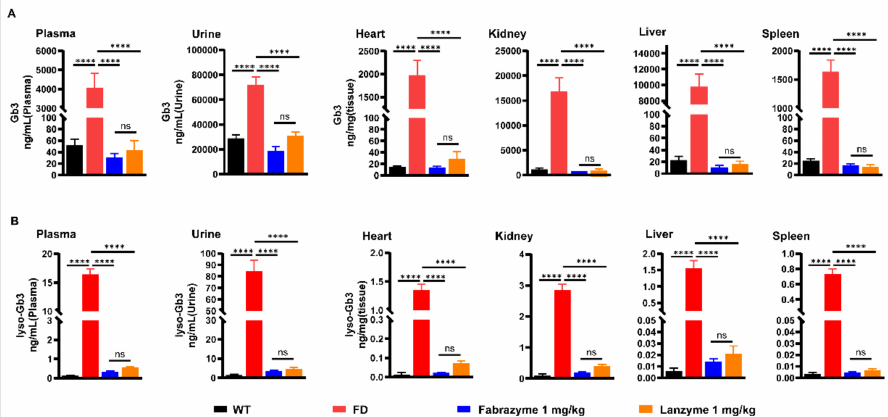
Figure 5. Efficacy of Lanzyme and Fabrazyme in clearing accumulated Gb3 ( A ) and lyso-Gb3 ( B ) in FD mice. Gb3 and lyso-Gb3 concentrations in plasma, urine, heart, kidney, liver, and spleen were analyzed 7 days after the last infusion of either Lanzyme or Fabrazyme at 1 mg/kg doses. Data are presented as mean ± SEM ( n = 8). **** p < 0.0001, ns is non-significant. Statistical significance is shown on top of each Fabrazyme group and indicates no significant difference between Fabrazyme and the same dose of